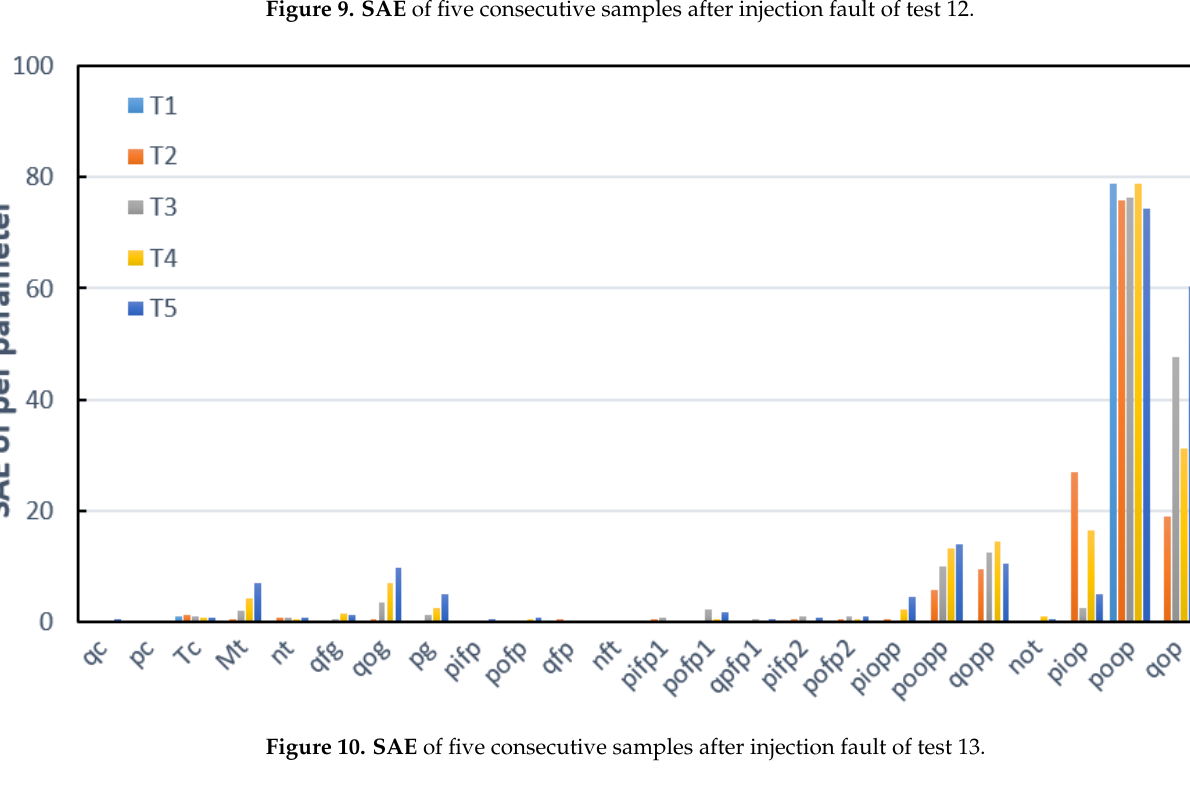
Figure 9. SAE of five consecutive samples after injection fault of test 12.